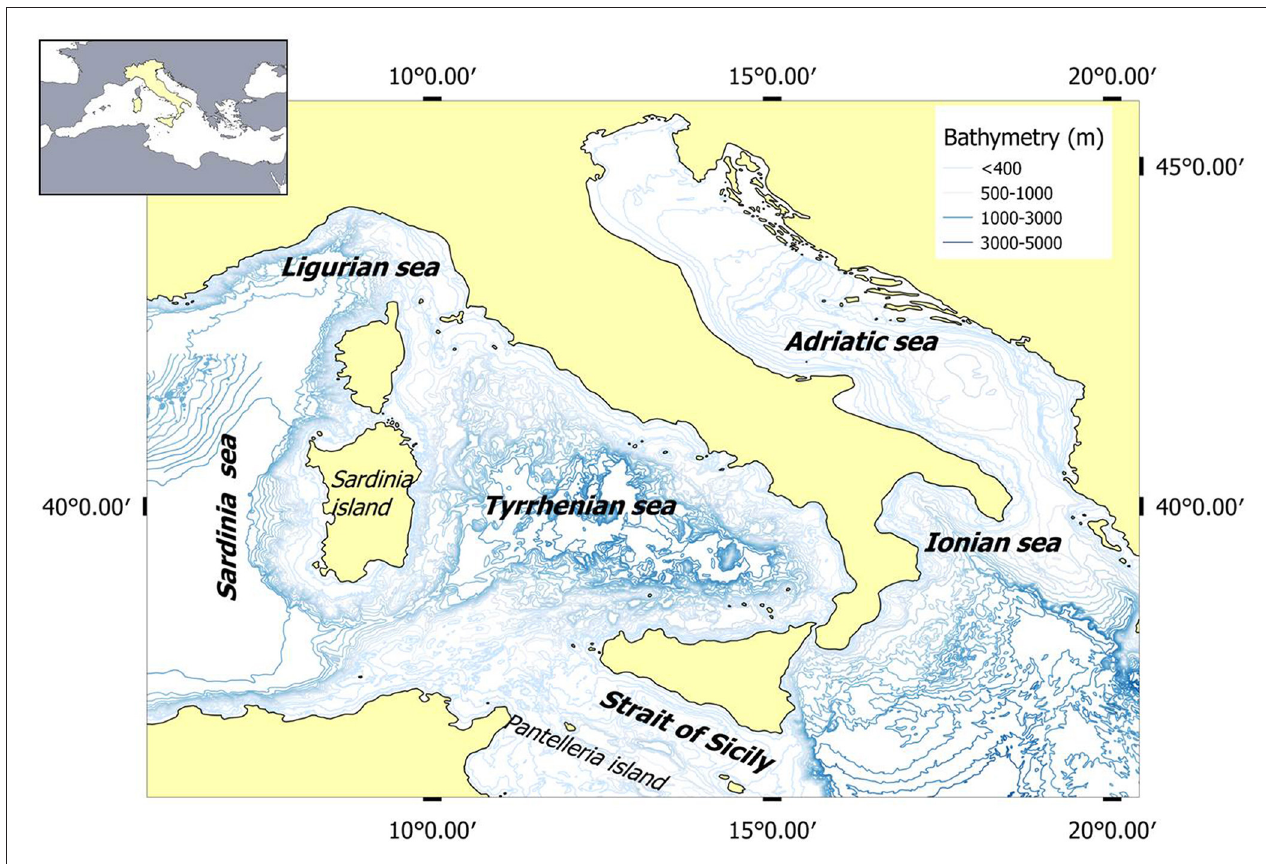
FIGURE 1 | Map of the study